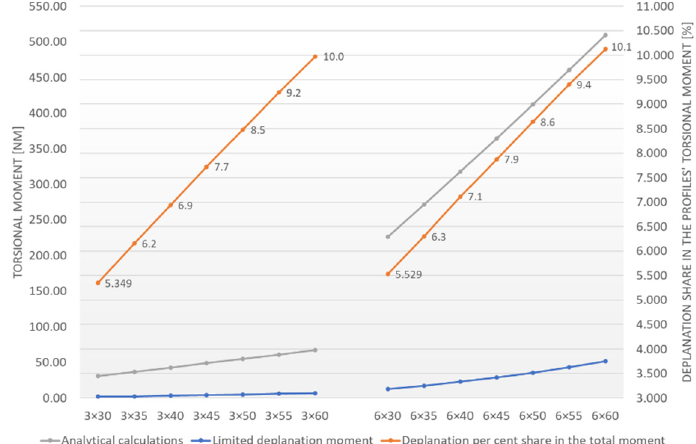
Figure 9. Limited deplanation share in the Ms total torsional moment affecting the unexpanded test sets.